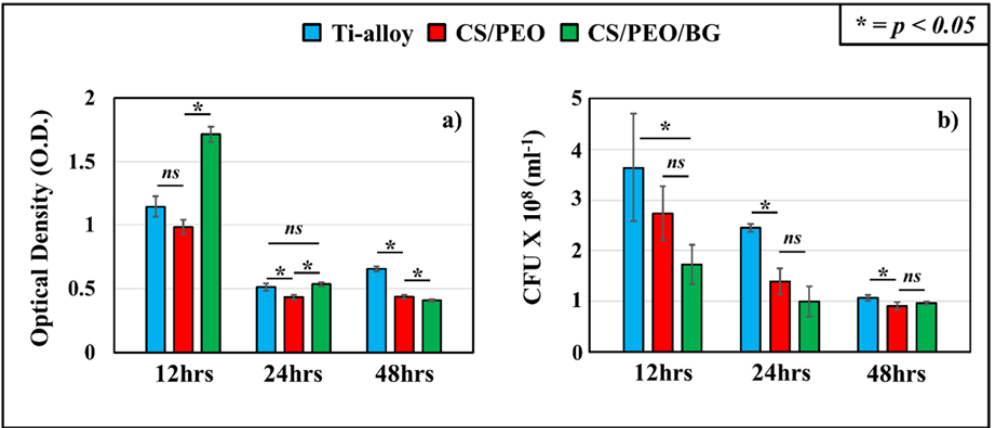
Figure 9. Experimental time-lapse results and statistical validation of ( a ) OD measurement related to Microbial viability assay and ( b ) CFU counting on the three substrates labeled with three different colors.